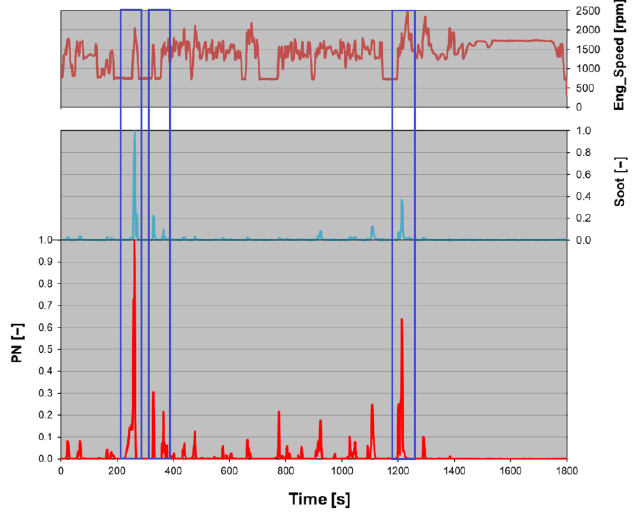
Figure 5. WHTC engine speed profile, PN, and Soot emitted engine-out in a typical test. PN and Soot are dimensionless.